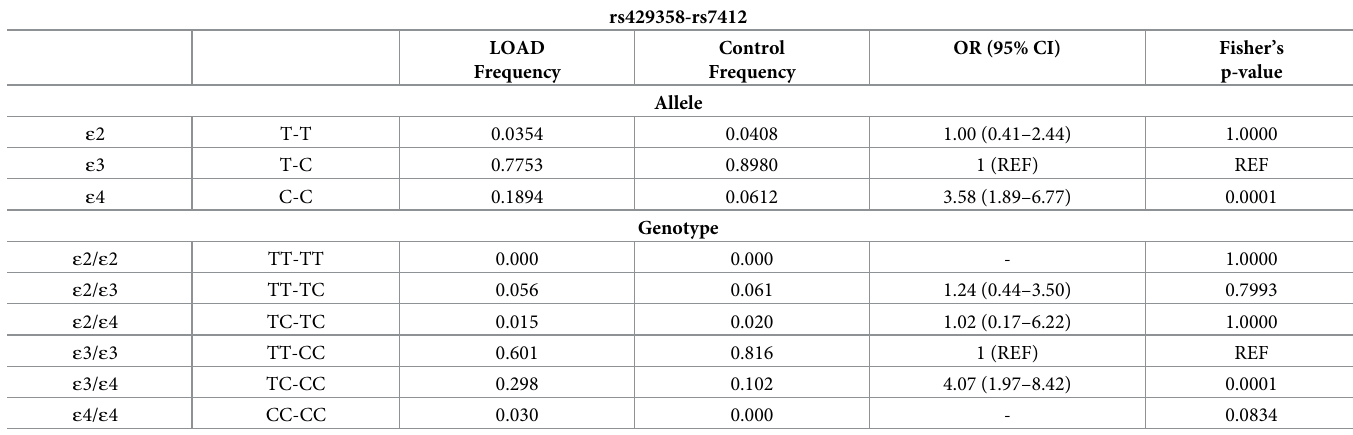
Table 4. Allele and genotype frequencies of APOE ε 2, ε 3 and ε 4 in peripheral blood samples of LOAD patients and age-matched cognitively normal